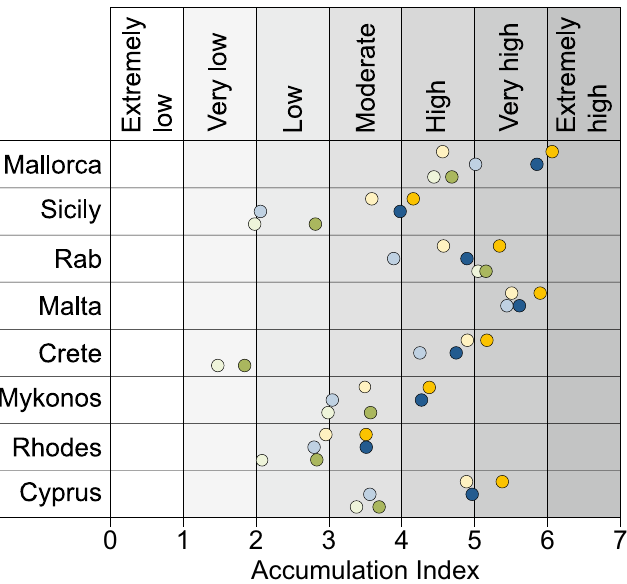
Figure 4. Accumulation Index of the 24 selected beaches. The AI calculated for the low season (LS) are given by the light colors and the AI for the high season (HS) by the dark colors. T beach : yellow, L beach : blue and R beach : green.